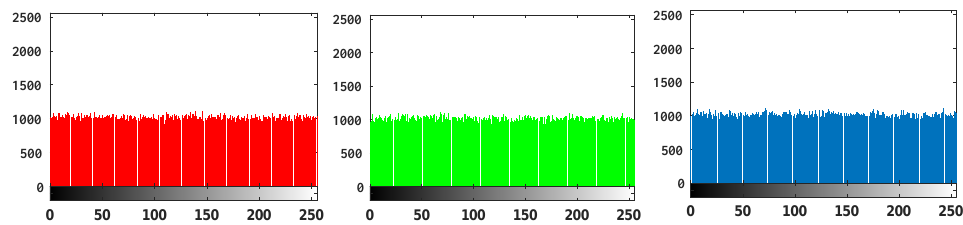
Figure 6. Histograms of the R, G and B of the encrypted Baboon